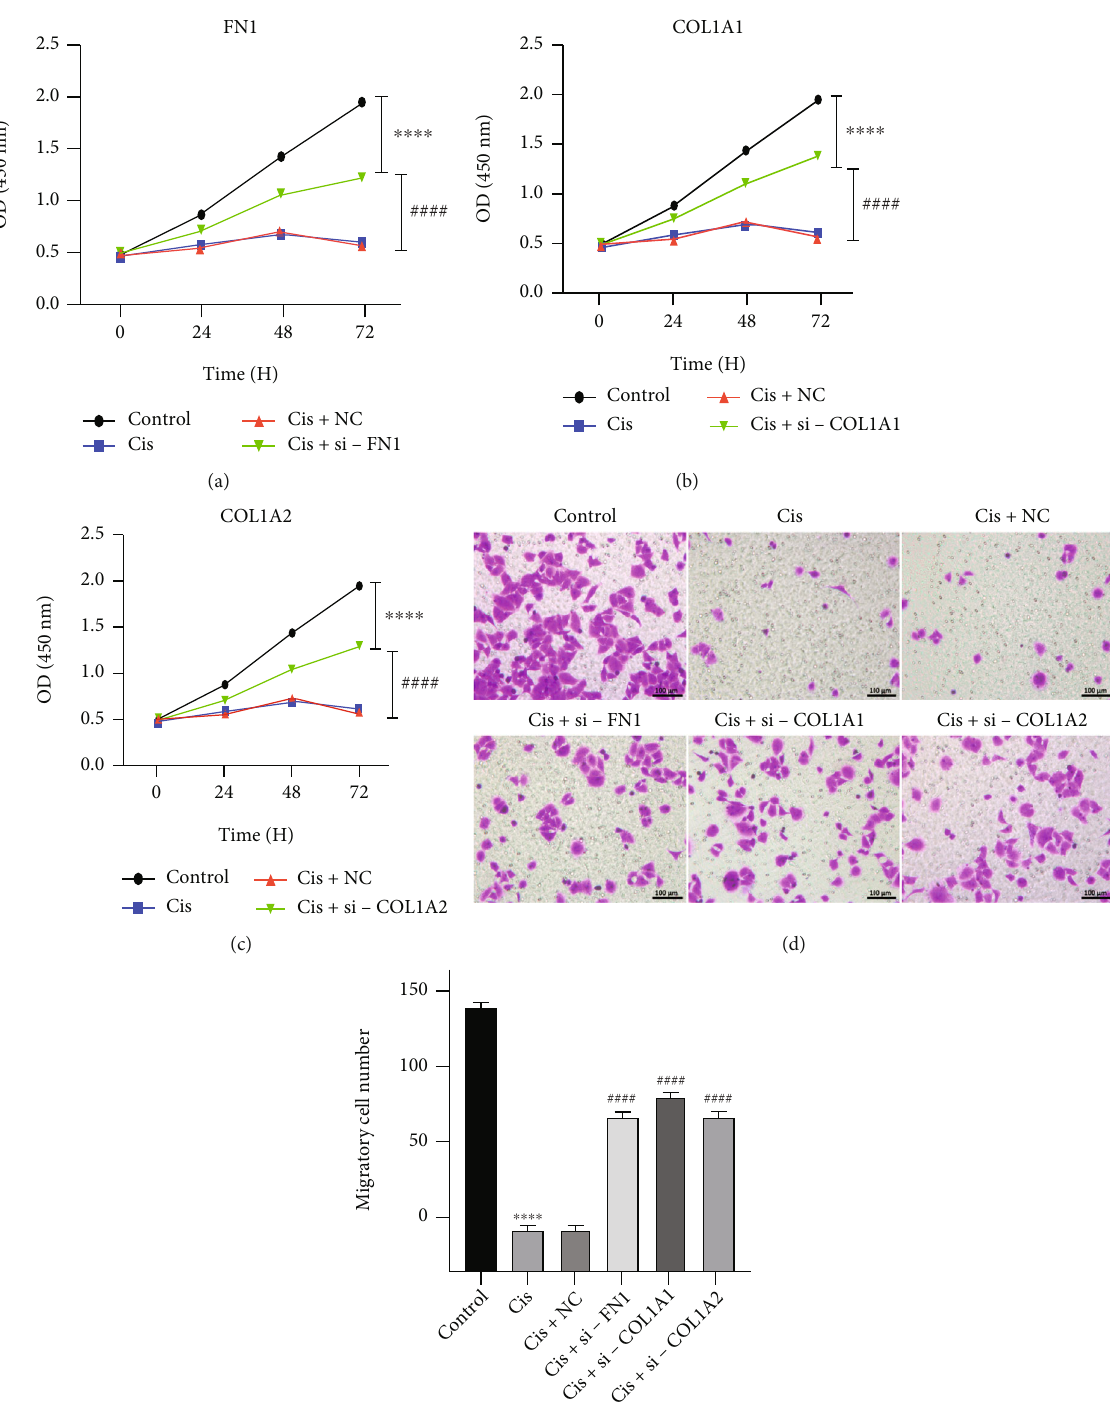
Figure 7: FN1, COL1A2, and COL1A1 enhance cisplatin sensitivity in osteosarcoma cells. (a – c) The e ff ects of FN1, COL1A2, or COL1A1 knockdown on cell viability of U2OS cells were measured by CCK-8 assay ( N = 3 ). (d and e) The migration capacity of FN1, COL1A2, or COL1A1 knockdown U2OS cells treated with cisplatin was analyzed by transwell assays. ∗∗∗ ∗ p < 0 : 001 compared with the control group and #### p < 0 : 001 compared with the Cis+NC